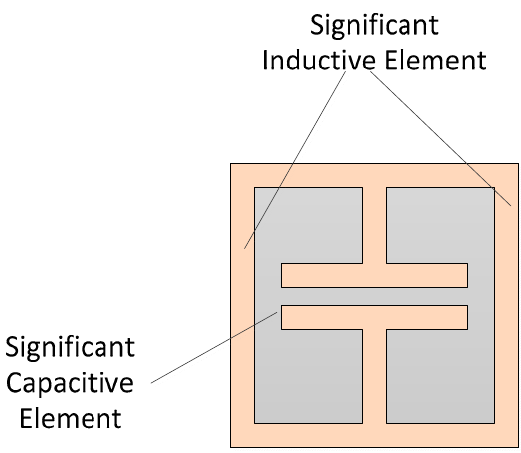
Figure 9. Multi-parameter Sensor Tag—Adapted from Reference [127].